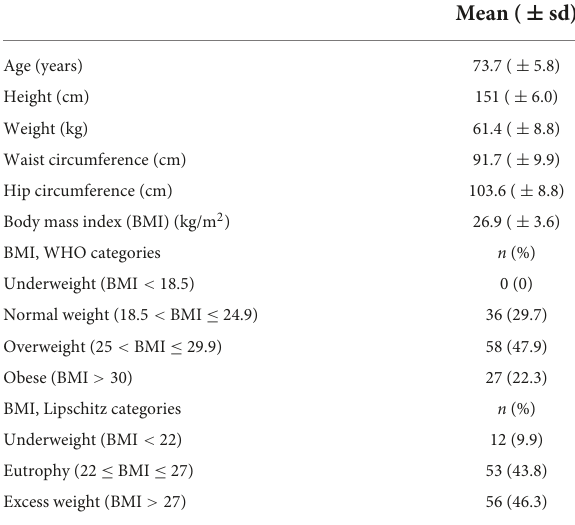
TABLE 2 Anthropometric characteristics and body mass index categories of participating older women ( n =